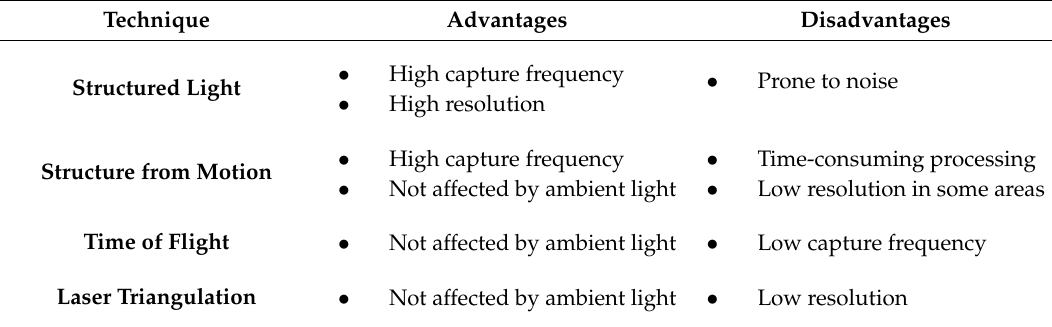
Table 1. Comparison of 4D full-field acquisition